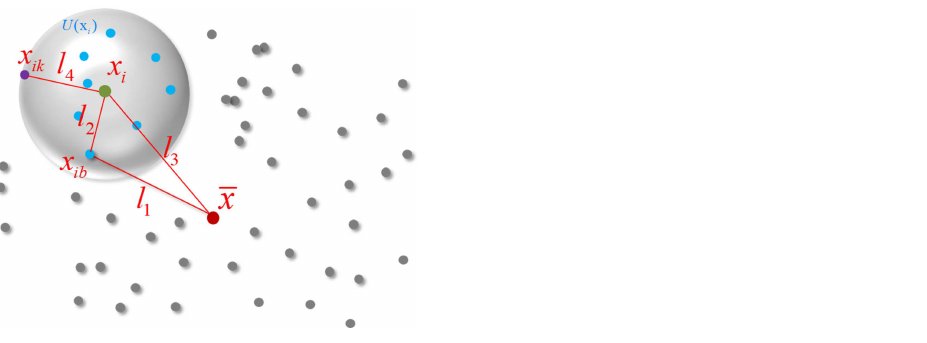
Figure 3. TIF. The points in blue are the points in U ( x i ) . The TIF of ( x ib ) is represented by Euclidean distances l 1 , l 2 , l 3 and l 4 .